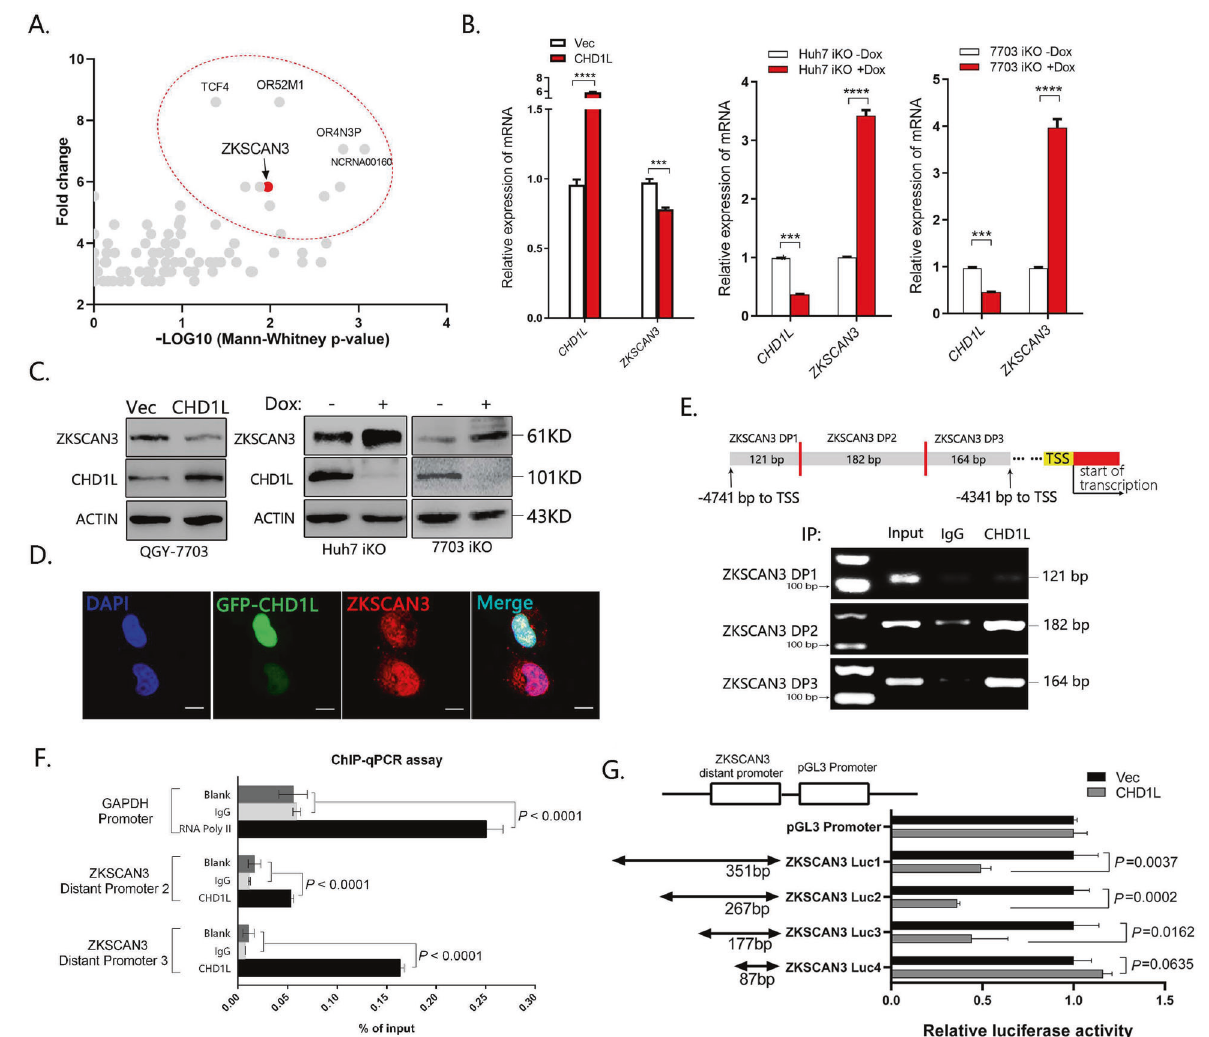
Fig. 4 CHD1L inhibits ZKSCAN3 transcription. A Visualization results of CHIP-seq by anti-CHD1L. Quantitative real-time-PCR (qRT – PCR) and WB were performed to determine the impact of CHD1L knockout or overexpression on mRNA ( B ) and protein ( C ) expression of ZKSCAN3 in Huh7 and QGY-7703 cells (*** p < 0.001, **** p < 0.0001, Student ’ s t test). The Dox-induced CRISPR/Cas9 system (1 μ g/ml, 72 h) was applied to knockout CHD1L in Huh7 and QGY-7703 cells, and the β -actin was used as loading control (referred to as ACTIN). D Representative images of CHD1L and ZKSCAN3 immuno fl uorescence staining in QGY-7703 cells transfected with GFP-tagged CHD1L. The stained cells were observed using confocal fl uorescence microscopy. Scale bar represents: 10 μ M. Images/immunoblots are representative of three independent experiments. Dox, Doxycycline. E , F Predicted CHD1L-binding site (ZKSCAN3 DP1, DP2 and DP3) within a region between 4741 to 4341 bp upstream of the TSS of ZKSCAN3 was evaluated by ChIP assay with anti-CHD1L IP in QGY-7703 cells. Anti-IgG IP was used as a negative control ( E ). ChIP-PCR was used to validate the binding of CHD1L to the identi fi ed promoter region of ZKSCAN3 in QGY-7703 cells ( F ). G Luciferase reporter assay in QGY-7703 cells using different fragments of ZKSCAN3 promoter after transfection with CHD1L or Vector, n = 3 biologically independent samples; data shown are mean ± SD. A two-sided Student ’ s t test was used to generate p (Fig. S3A). On the contrary, when using 3-MA to prevent autophagic degradation or overexpressing paxillin , the strong migratory ability induced by CHD1L overexpression was also signi fi cantly abolished (Fig. S3B, C). All these results demonstrated that CHD1L-ZKSCAN3 axis might promote HCC migration and metastasis potentially through autophagic degra- dation of Paxillin.